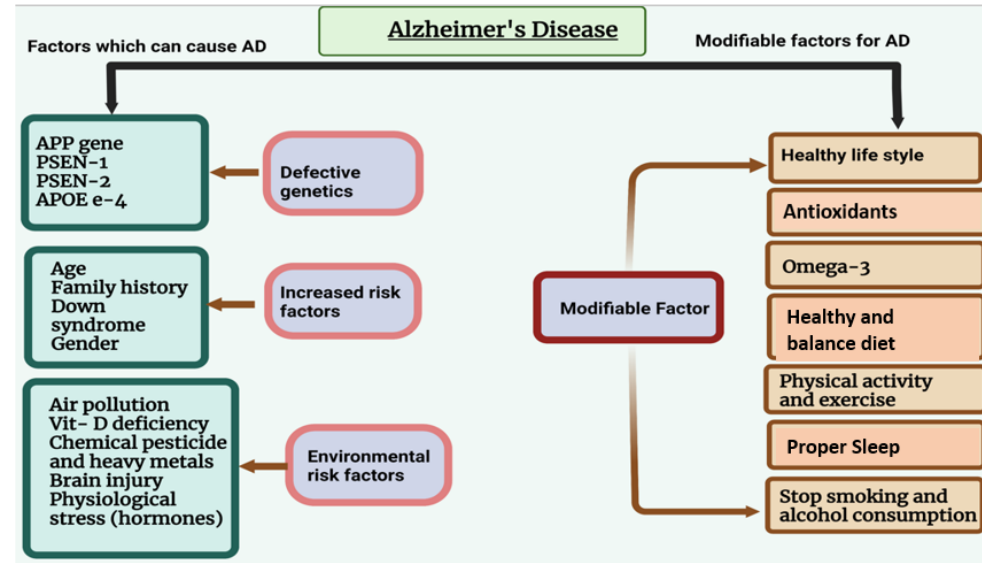
Figure 1. Non-modifiable and modifiable risk factors for Alzheimer’s disease. Non-modifiable factors that may cause AD are age, sex, and defective genetics. Modifiable risk factors (e.g., obesity, smoking, drinking, heart disease, physical inactivity) can play a major role as preventive factors.